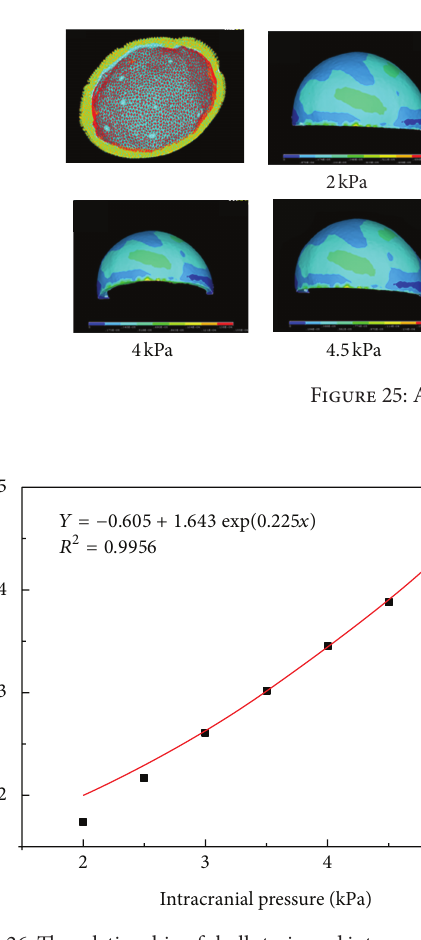
Figure 26: The relationship of skull strain and intracranial